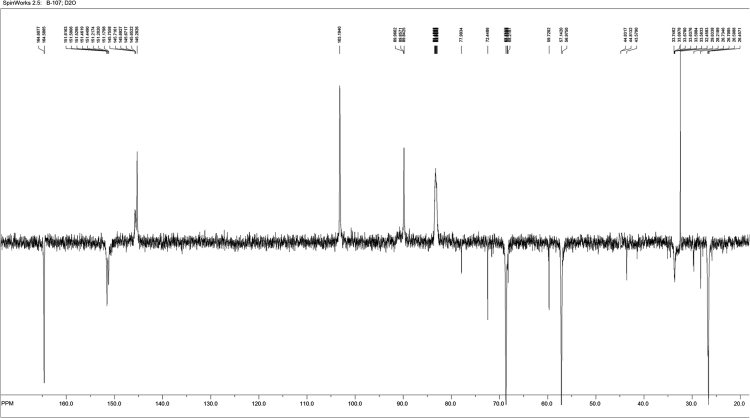
13C NMR spectrum of L~pppddU.